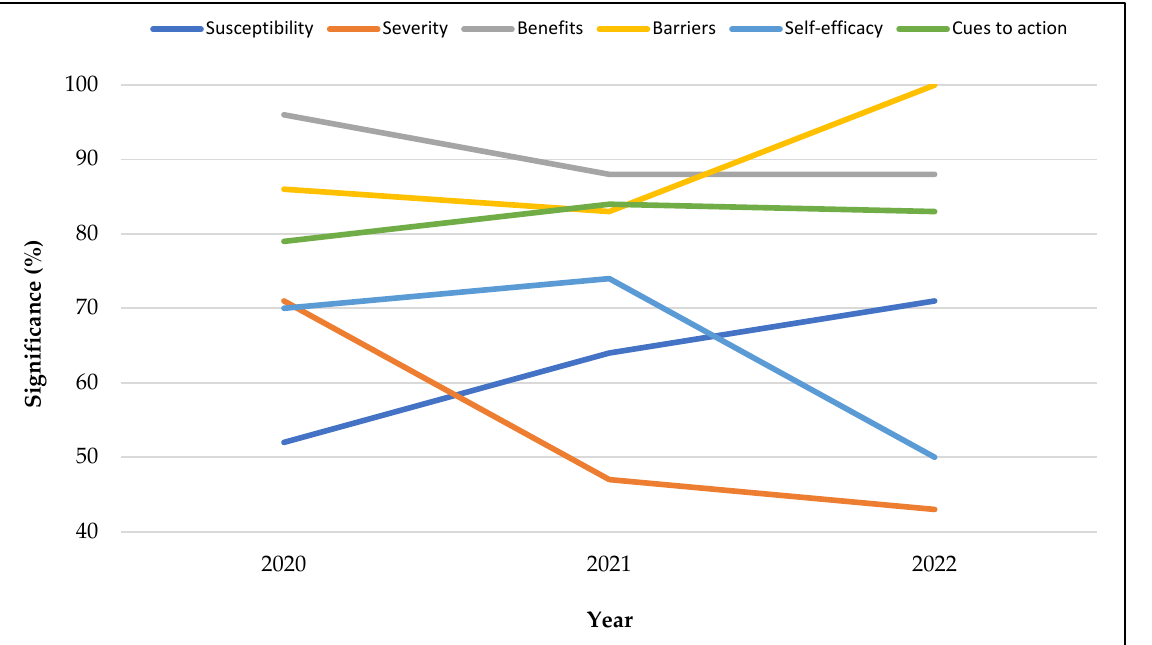
Figure 6. Health belief model constructs associated with vaccination intention by data collection year.